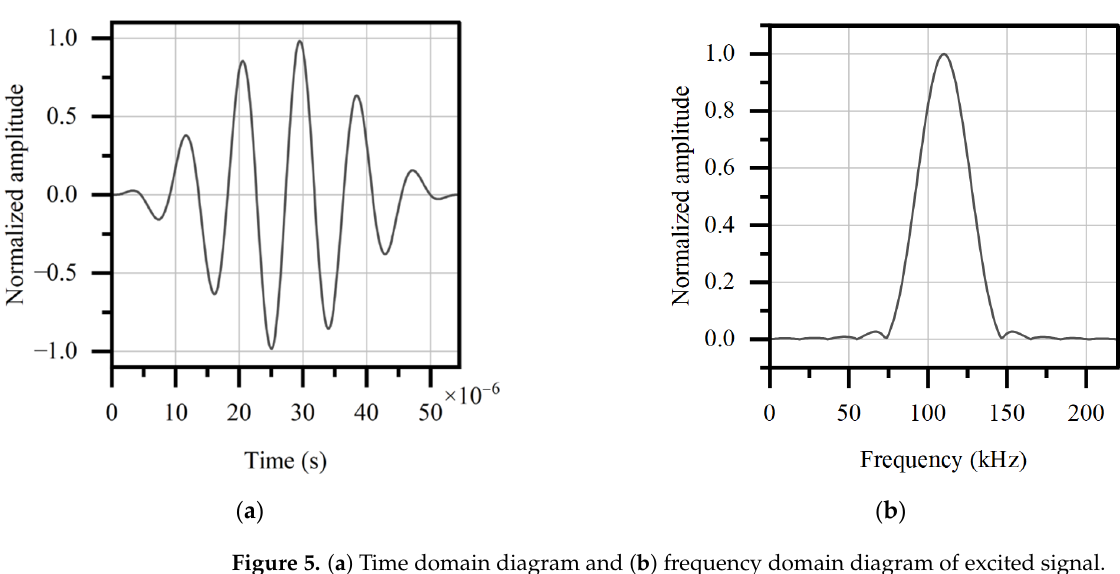
Figure 5. ( a ) Time domain diagram and ( b ) frequency domain diagram of excited signal.